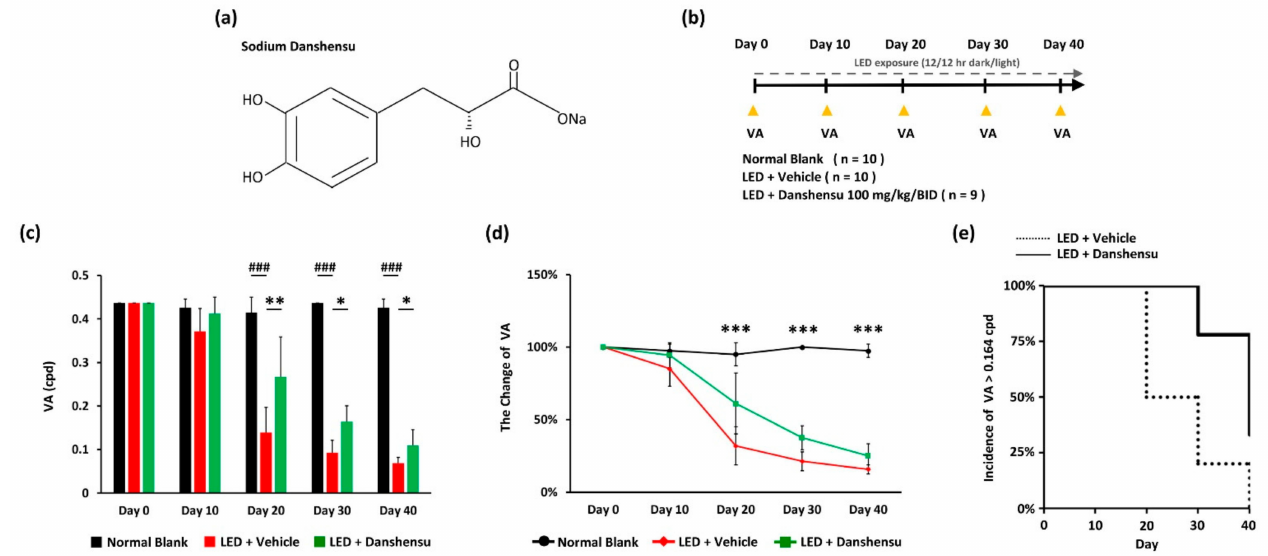
Figure 1. Effect of danshensu on light-evoked visual acuity (VA) deterioration. ( a ) Chemical structure of sodium danshensu; ( b ) Timeline of experimental design; ( c ) Representation of the VA threshold. Data are mean ± SE. Mann-Whitney U test. ### p < 0.001, compared with the blank group. ** p < 0.01, and * p < 0.05, compared with the vehicle group; ( d ) Relative change in VA. Data are mean ± SE. Kruskal–Wallis test. *** p < 0.001; ( e ) Incidence rate of VA > 0.164